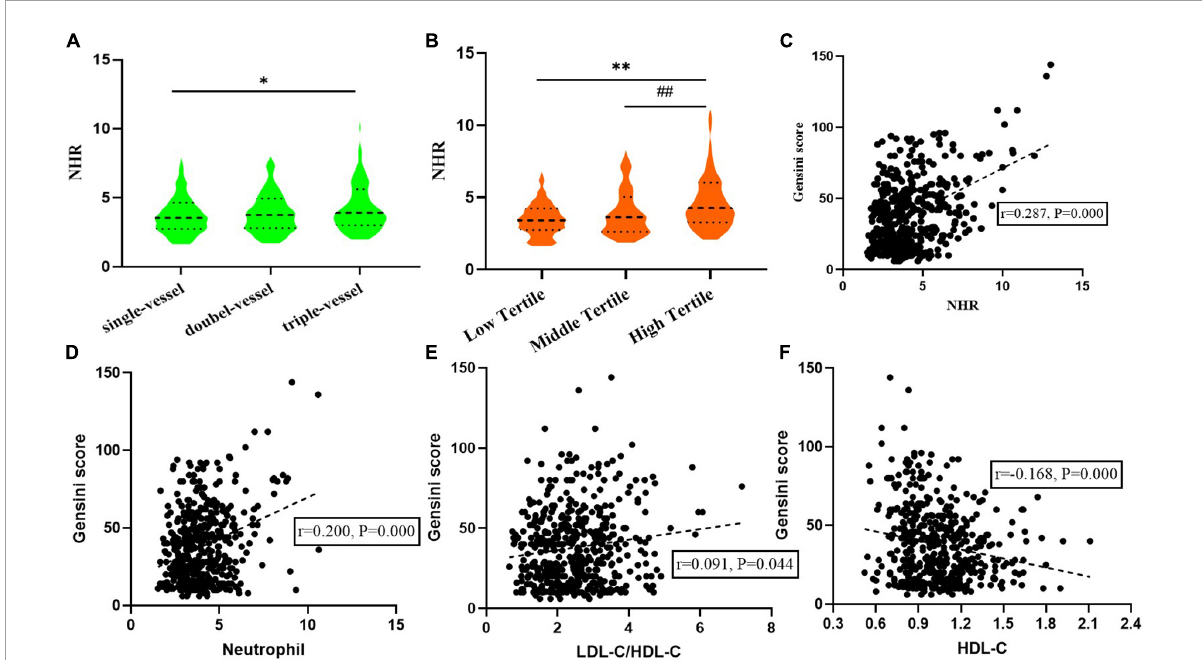
FIGURE2 Relationship between neutrophil to HDL-C ratio (NHR) and the severity of coronary artery disease. (A) Relationship between NHR and the number of coronary artery lesions. (B) NHR levels from low to high tertile groups according to Gensini score. (C–F) Correction between NHR, Neutrophil, LDL-C/HDL-C, HDL-C, and Gensini score. ∗ P < 0.01 compared with single-vessel group. ∗∗ P < 0.01 compared with low tertile group. ## P < 0.01 compared with middle tertile